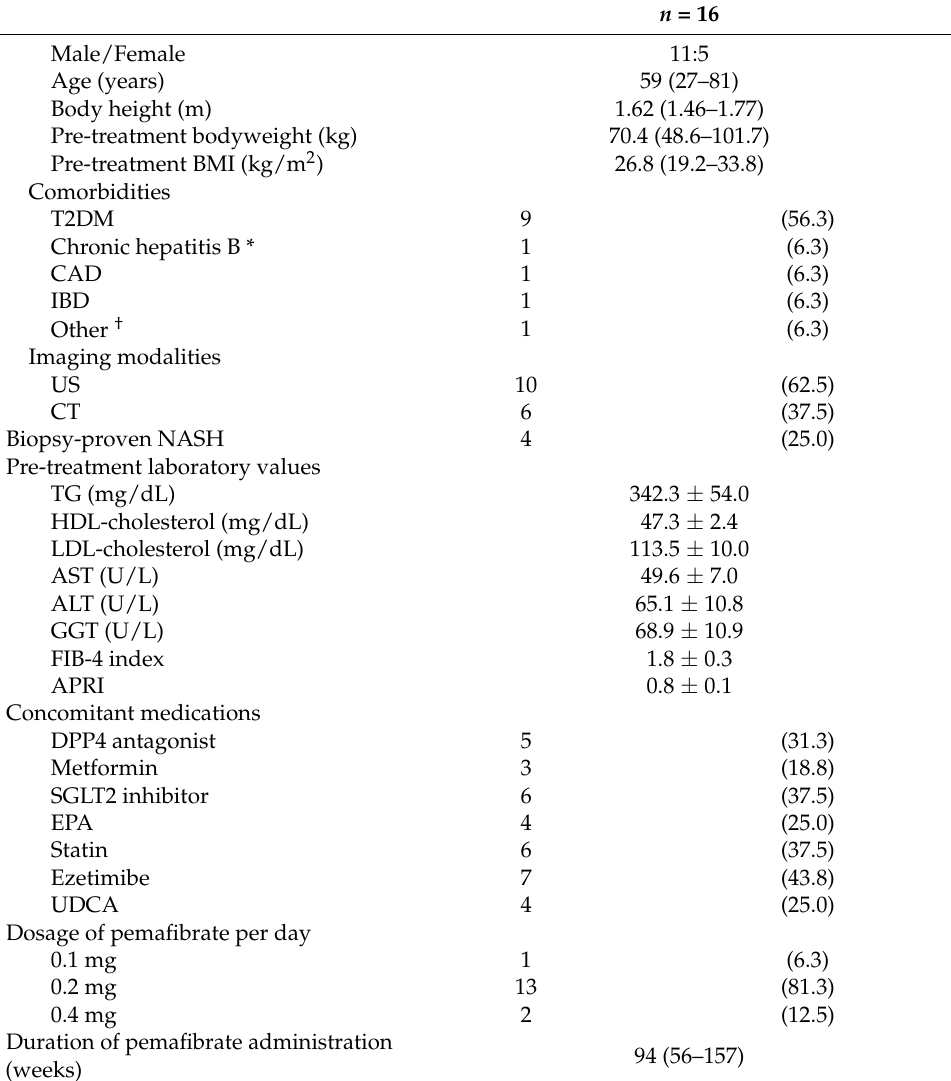
Table 1. Characteristics of the 16 patients treated with